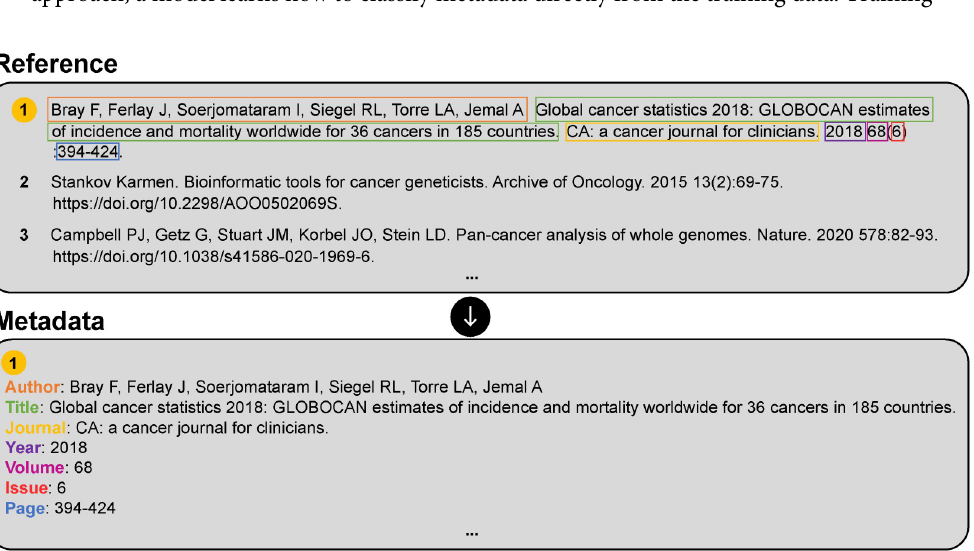
Fig 1. Example of bibliographic reference parsing. In reference parsing, the input is a single reference string, and the output corresponds to metadata such as the author name, title, and journal. Parsed metadata field values are typically stored in machine-readable XML or JSON